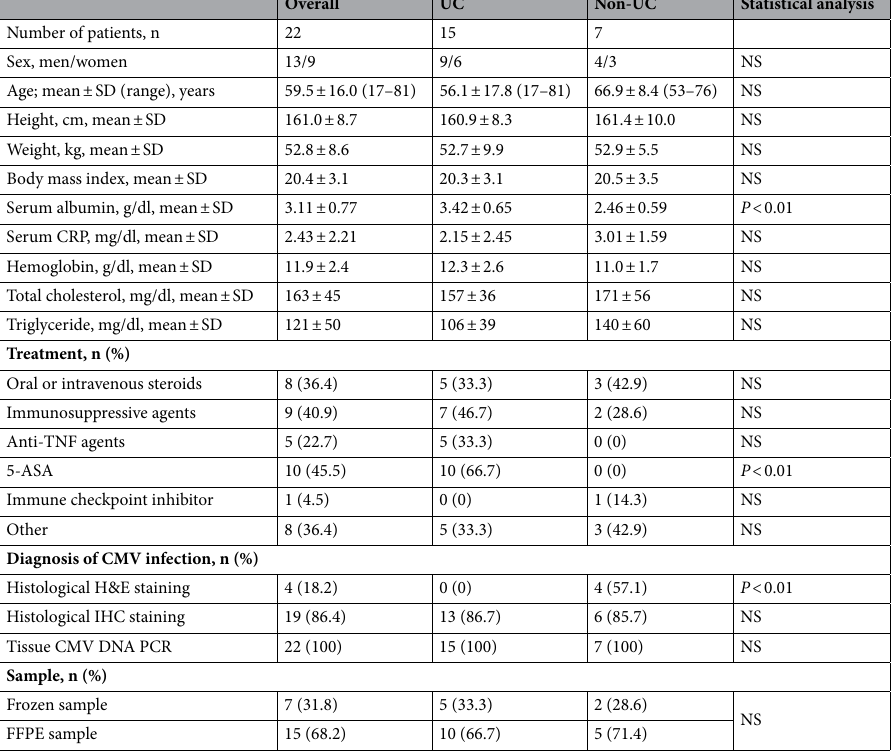
Table 3. Comparison of the patient characteristics between the UC and non-UC groups. H&E hematoxylin and eosin, IHC immunohistochemistry, FFPE formalin-fixed